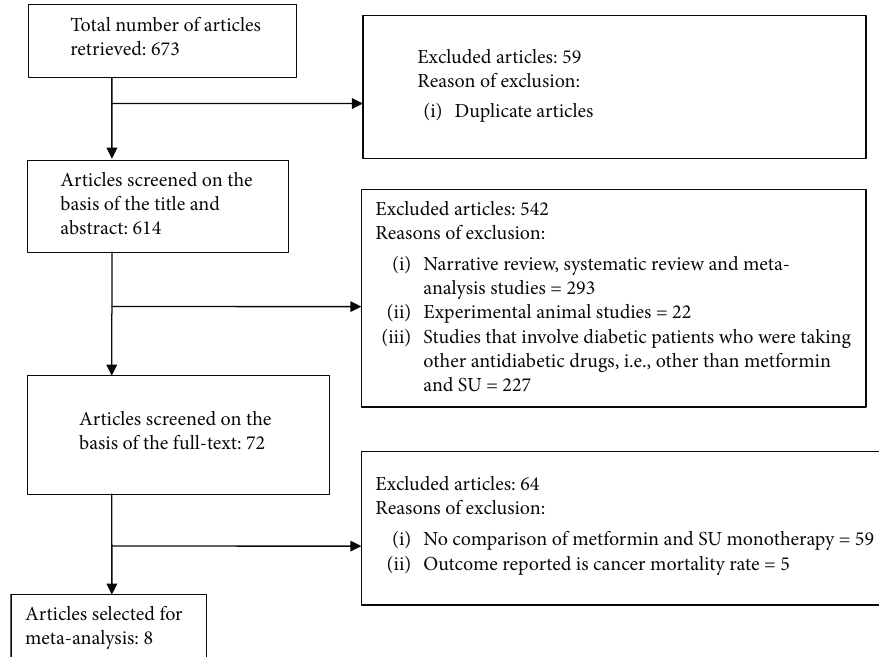
Figure 1: Flow chart of the search result and selection of studies for inclusion in the